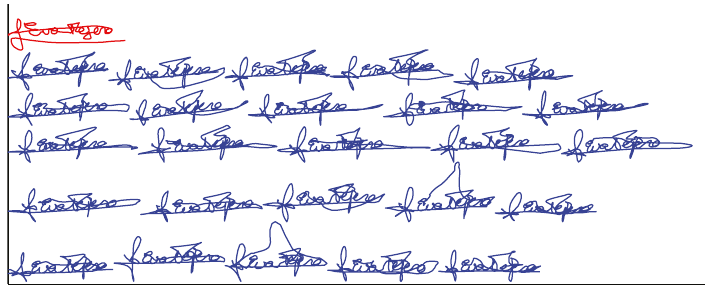
Figure 5: A forgery signature (shown on top) that was misclassified using the DTW system while it was correctly classified using the combined